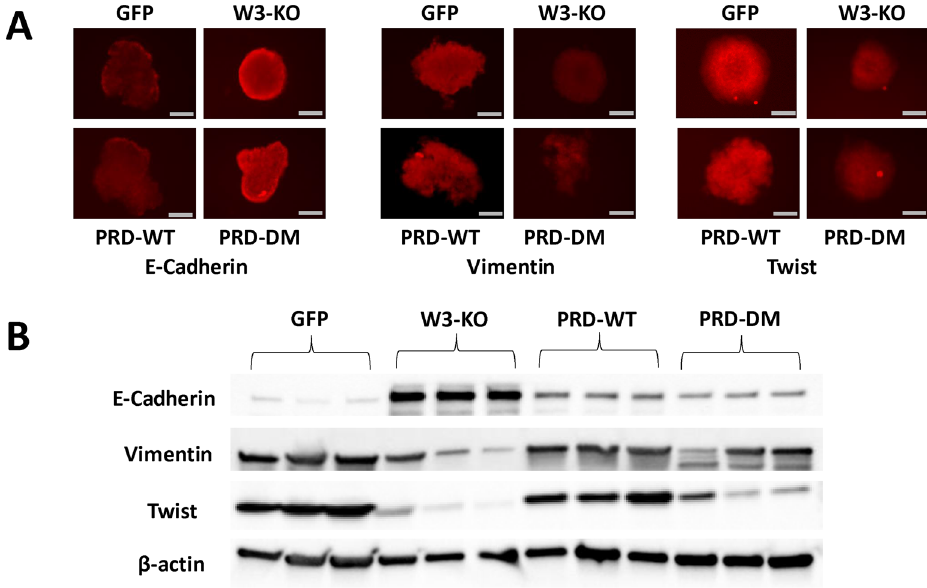
Figure 7. Phosphorylation of the WAVE3 PRD domain is required for the WAVE3-mediated regulation of the EMT-program and for the YB1-mediated regulation of the cancer stem cell niche: Immunofluorescence and Western Blot data. ( A ) Representative micrographs of tumorspheres derived from parental 4T1 and its derivatives and immunostained with antibodies against the indicated proteins. Scale bar: 150 µm. ( B )